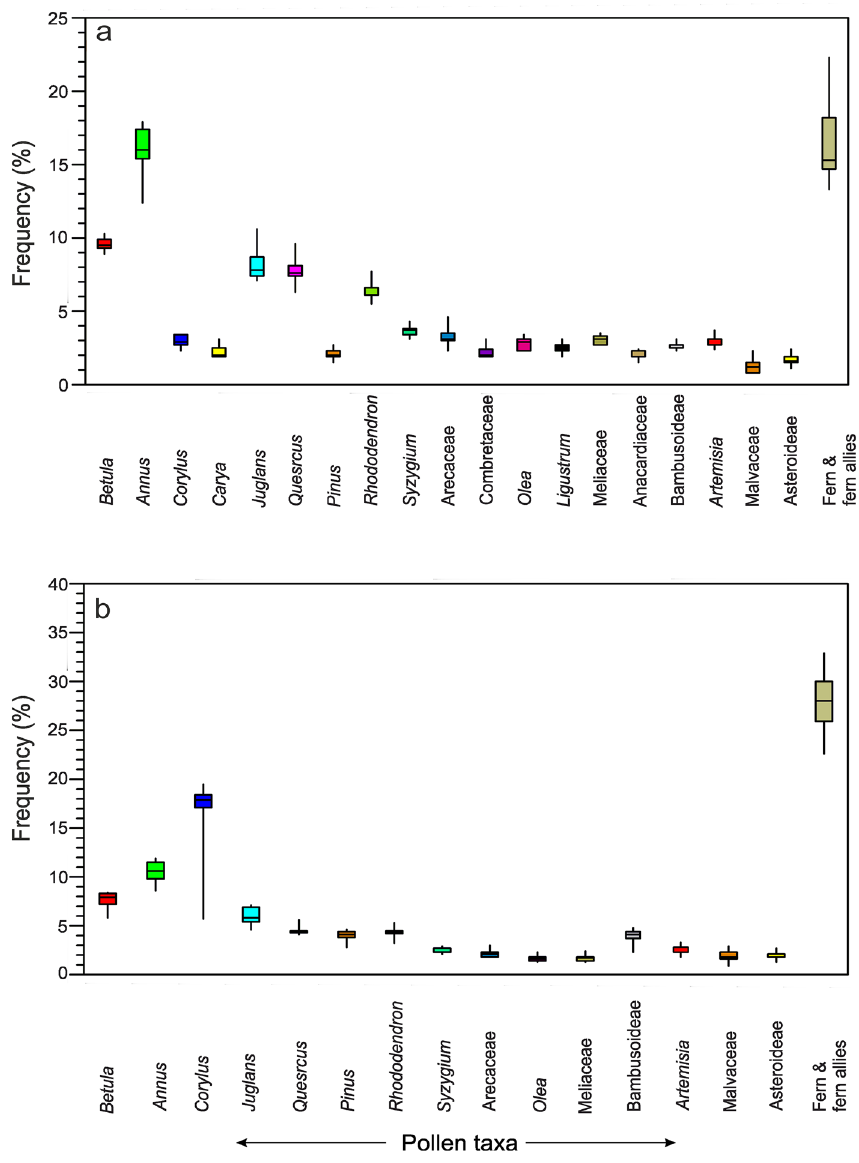
Figure 2. Box plots showing distribution of different pollen taxa in summer ( a) and winter feces ( b) samples.